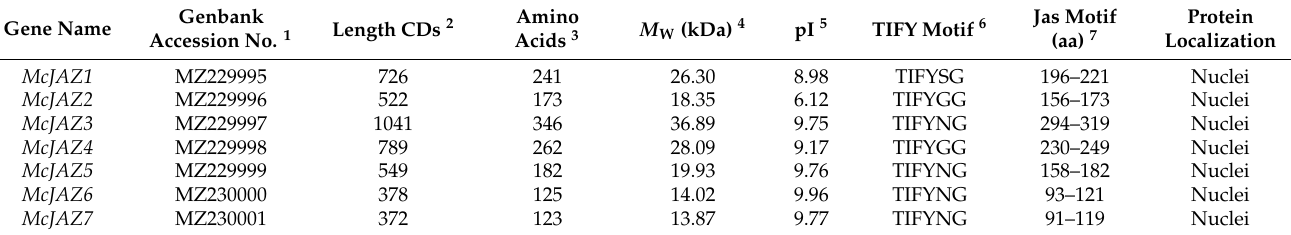
Table 1. Molecular characteristics of McJAZ genes in M. canadensis